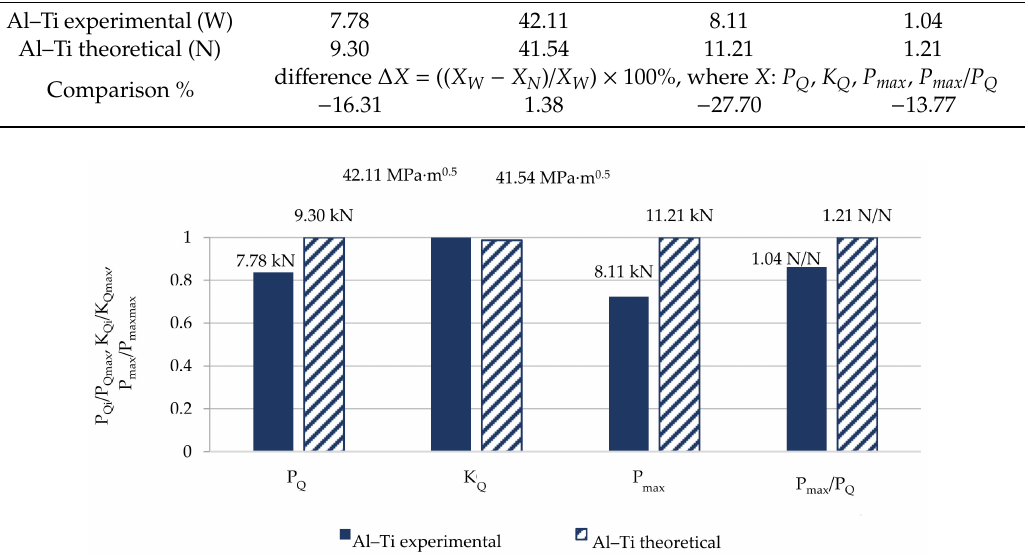
Figure 18. Normalized to 1 comparison of selected mechanical properties obtained experimentally and theoretically characterizing fracture toughness of, Al–Ti material for cryogenic